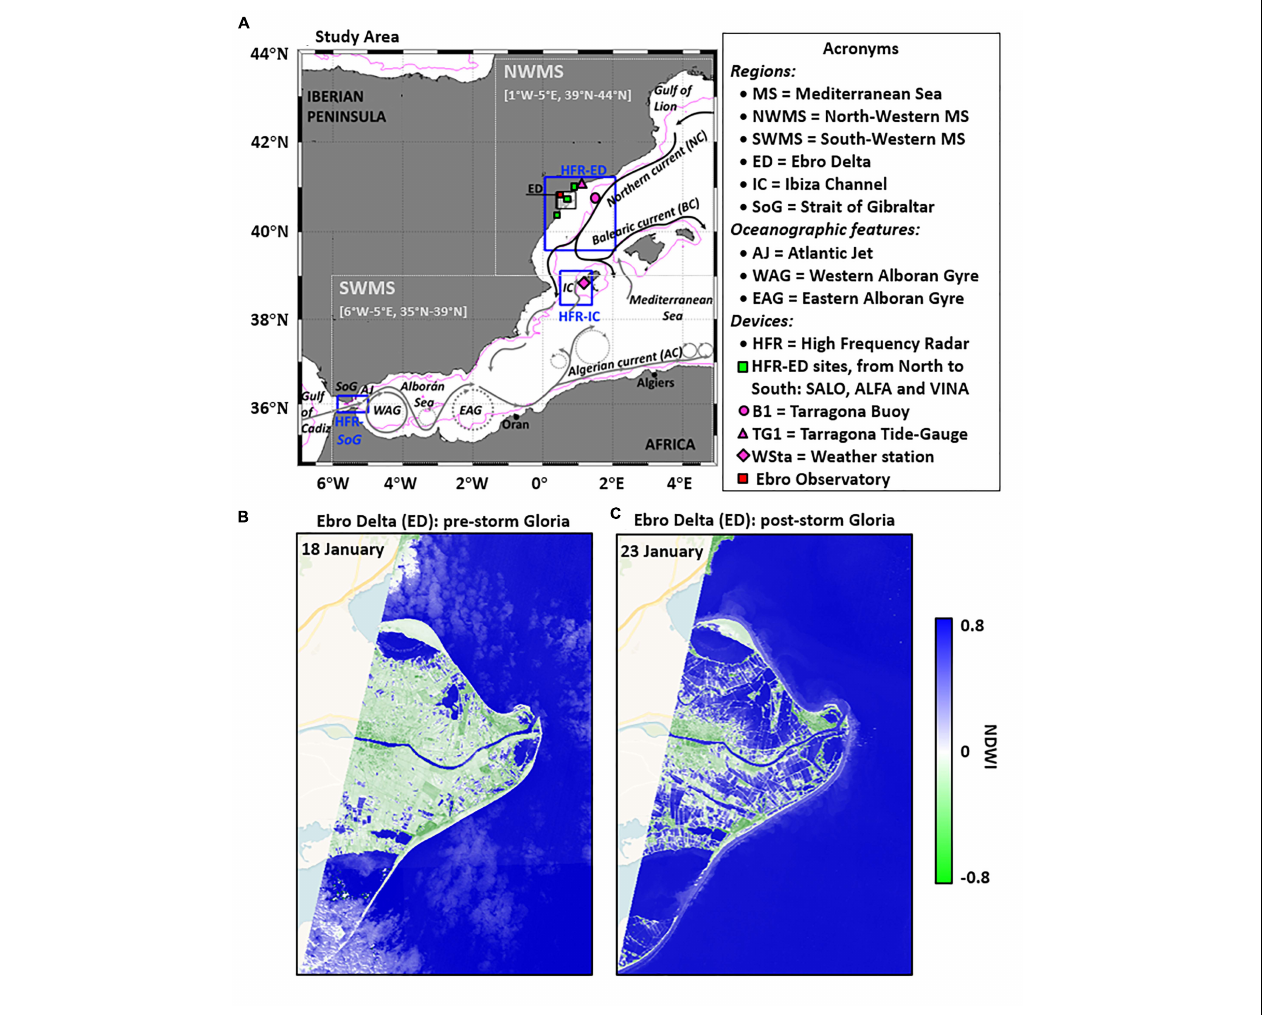
FIGURE 1 | (A) Map showing the main features of the surface circulation in the Western Mediterranean Sea (WMS). Acronyms definition provided on the right side. Blue boxes denote the footprint of three High-Frequency radar (HFR) systems; black box indicates Ebro Delta (ED) area. Bathymetric contour shows depth at 400 m. Dashed gray boxes denote the Northern and Southern WMS sub-basins. Green squares denote HFR-ED sites. Pink triangle, dot, and diamond represent Tarragona tide-gauge (TG1), Tarragona deep buoy (B1), and Ibiza Weather Station (WSta), respectively; (B,C) Daily maps of the Normalized Difference Water Index (NDWI) in the Ebro Delta for January 18 (B) and 23 (C) 2020, as derived from Sentinel-2 L1C mission (freely available at